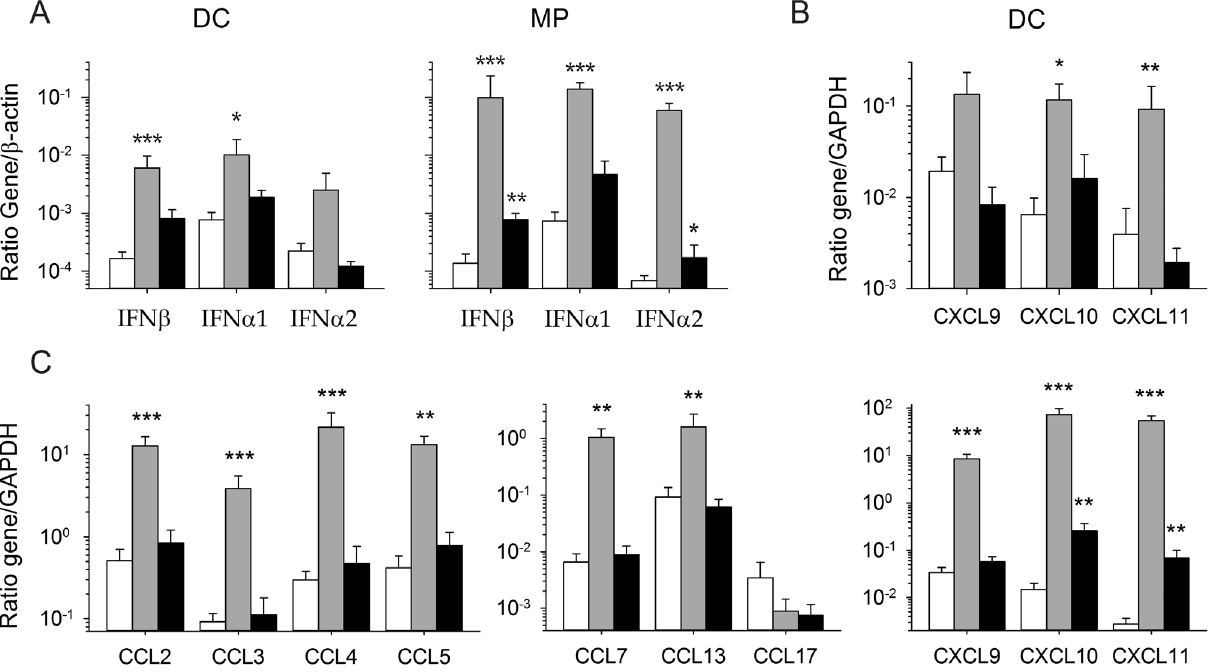
Figure 1. Production of type I IFN and chemokine mRNA in DC and MP infected with LASV and MOPV. We obtained mRNA from DC and MP 24 h after infection with LASV (black bars), MOPV (gray bars), or after mock infection (white bars). (A) The amounts of type I IFN mRNA produced by DC and MP are shown as a gene mRNA/ b -actin mRNA ratio. The synthesis of chemokine mRNA was evaluated with the GAPDH gene used as a housekeeping gene, in both DC (B) and MP (C). Results are expressed as the mean 6 standard error (SE) of 4 and 5 independent experiments, for LASV- and MOPV-infected cells, respectively. Significant differences between mock- and virus-infected cells are indicated as follows: * ( p , 0.05), ** ( p , 0.01), and *** ( p ,